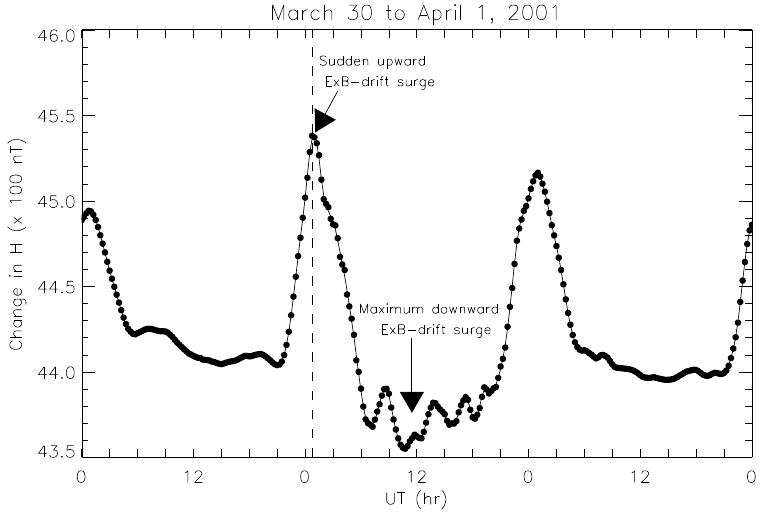
Fig. 10. The 1H (difference between the horizontal component of the geomagnetic field (H) at the equator and at non-equator regions) obtained from the magnetometer data at Hatizyo (23.46 ◦ N, − 152.18 ◦ E geomagnetic) and at Guam (4.57 ◦ N, − 145.24 ◦ E geomagnetic) to estimate vertical E × B